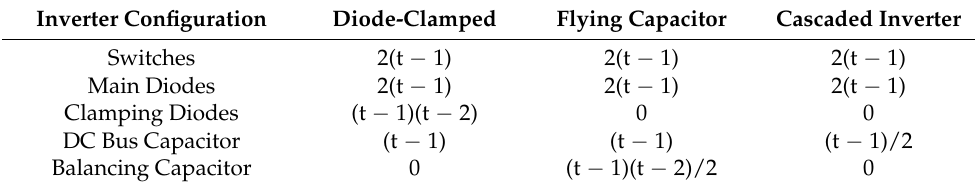
Table 1. Comparison of component count for conventional